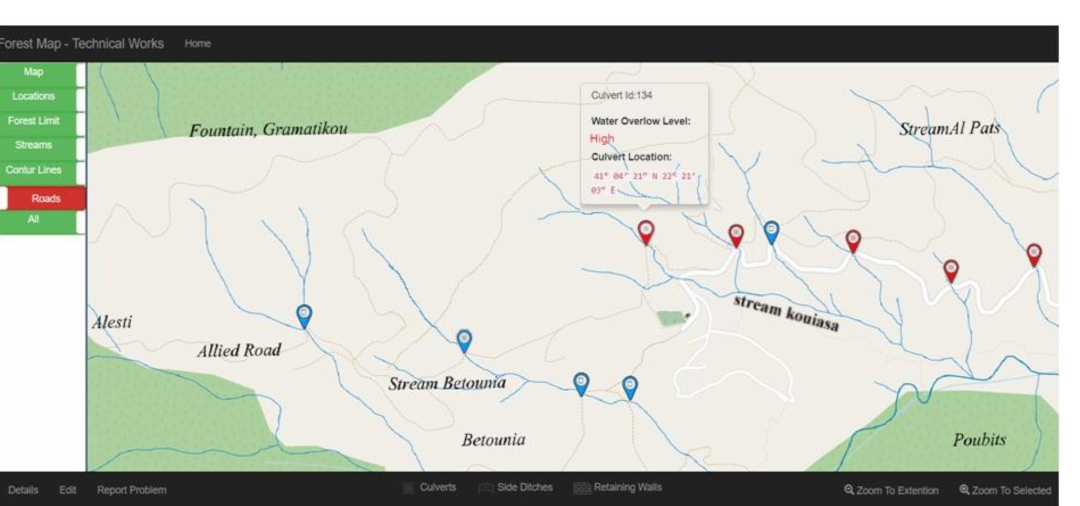
Figure 7. Display map of forest technical works at risk (indicated with red